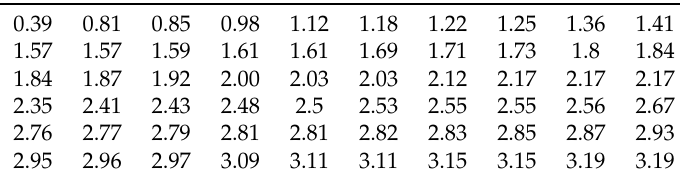
Table 11. Censored data with R = ( 20,0 ∗ 58,20 ) , T = 3.2, J =